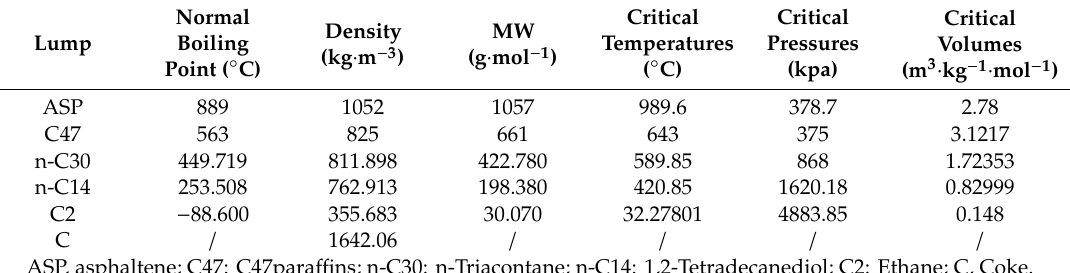
Table 2. Lumps and their properties utilized in plug flow reactor